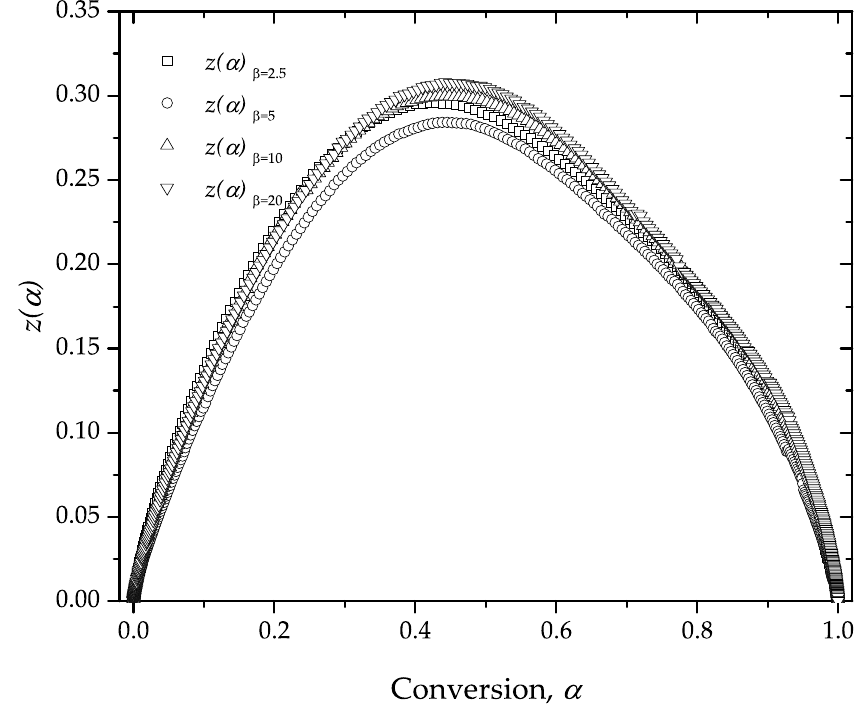
Figure 10. Calculated z ( α ) plots as a function of the conversion α , corresponding to the crosslinking of a partially bio-based epoxy resin for different heating